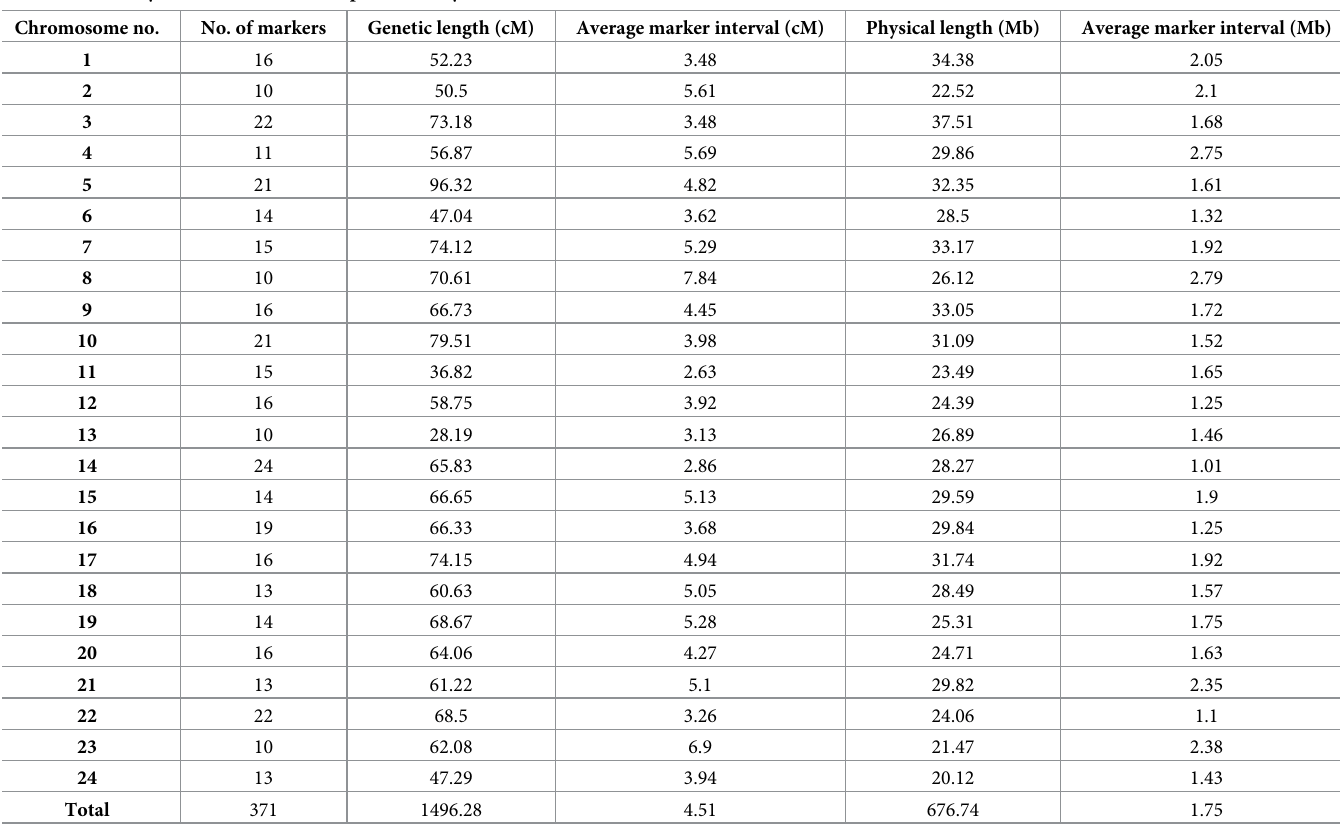
Table 1. Summary of markers used in the present study. Chromosome